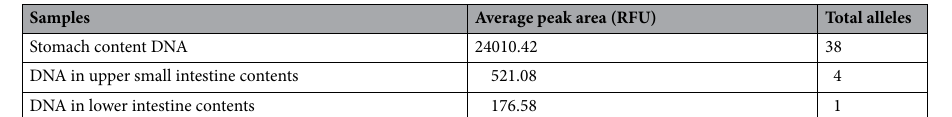
Table 6. The average peak area and the number of alleles in the STR curve map of the DNA amplification of the contents of different parts of the mouse digestive tract at 40 min after gavage.